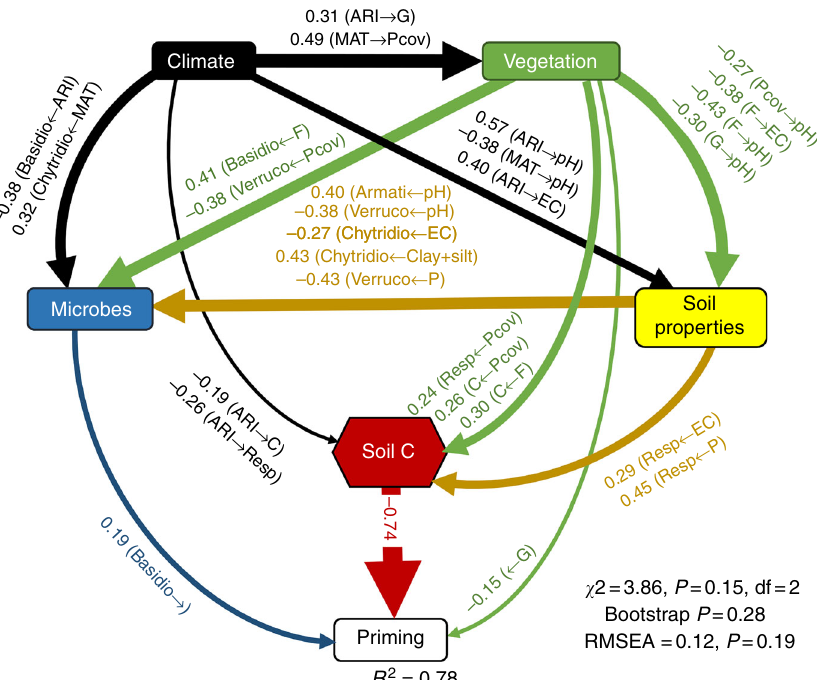
Fig. 2 Ecological predictors of the apparent soil priming effect. Structural Equation Model (SEM) describing the effects of multiple ecological predictors on the apparent soil priming effect ( n = 69). Numbers adjacent to arrows are indicative of the effect size ( p < 0.05) of the relationship. R 2 denotes the proportion of variance explained. Climate, soil properties and vegetation predictors are included in our models as independent observable variables; however, we group them in the same box in the model for graphical simplicity. Soil carbon (C) associated variables (soil microbial respiration and soil organic C content) are included as a composite variable in our model (hexagon). F = forest. G = Grasslands. SHR = Shrublands. C + S = Clay + silt. EC = Salinity. Resp = Basal microbial soil respiration. Basidio = % of Basidiomycota . Verruco = % of Verrucomicrobia . Armati = % of Armatimonadetes . Chytridio = % of Chytridiomycota . Pcov = % of plant cover. ARI = Aridity (i.e., 1-ARI). Locations with a higher aridity also support lower water availability). MAT = Mean annual temperature. There was a non-signi fi cant deviation of the data from the model ( χ 2 = 3.97, df = 2; p = 0.14; RMSEA p = 0.18)